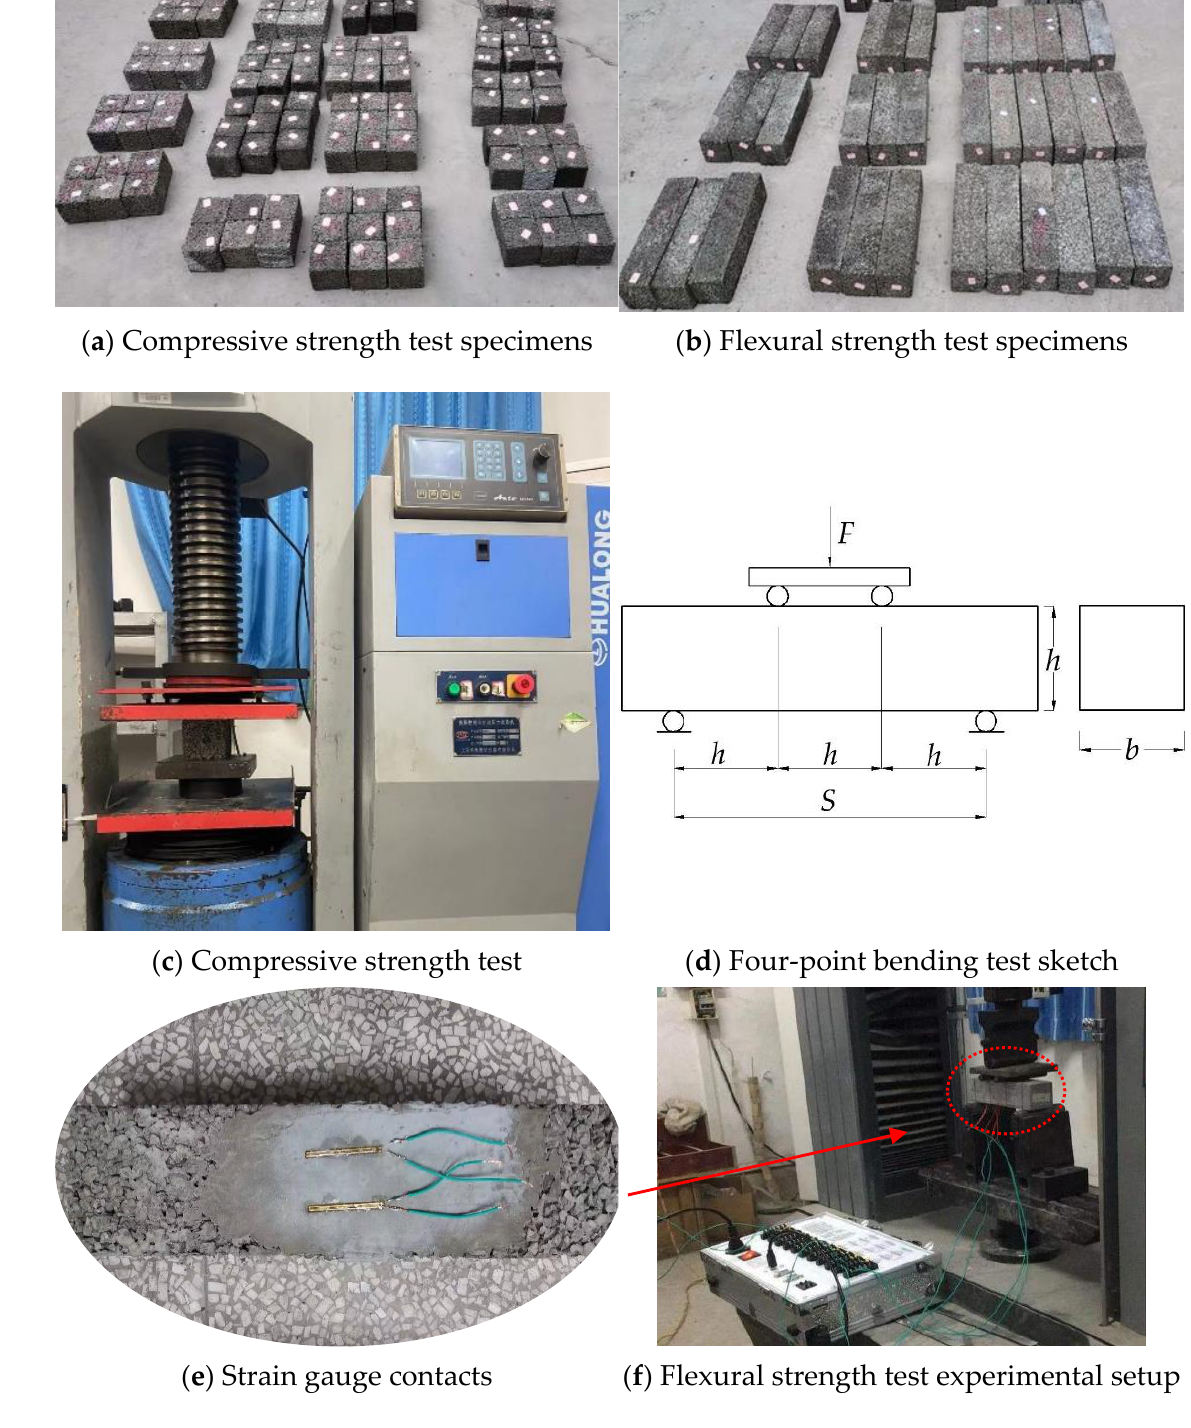
Figure 3. Bending stress–strain schematic. The flexural stiffness of the specimens was tested at 28 days. Its test procedure was roughly similar to the flexural strength test; the only difference was the loading manner.